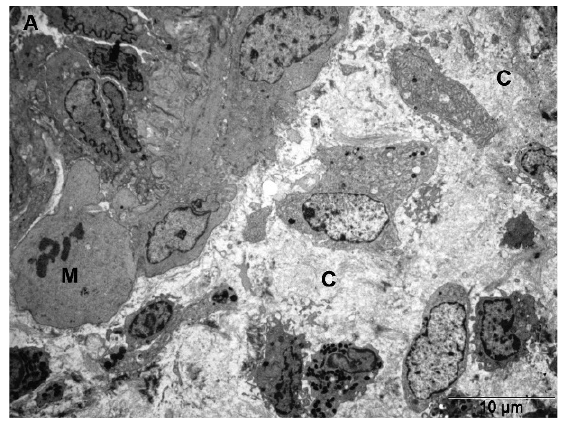
Figure 1 - Dence collagen deposition (c) is shown in the anastomotic area. M: mitosis and new vessel in group 4.